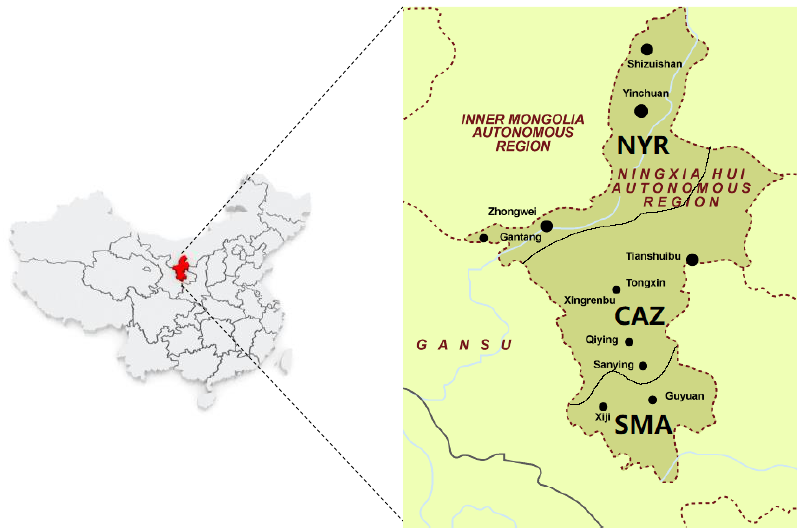
Figure 1. China Ningxia regional division and site distribution.